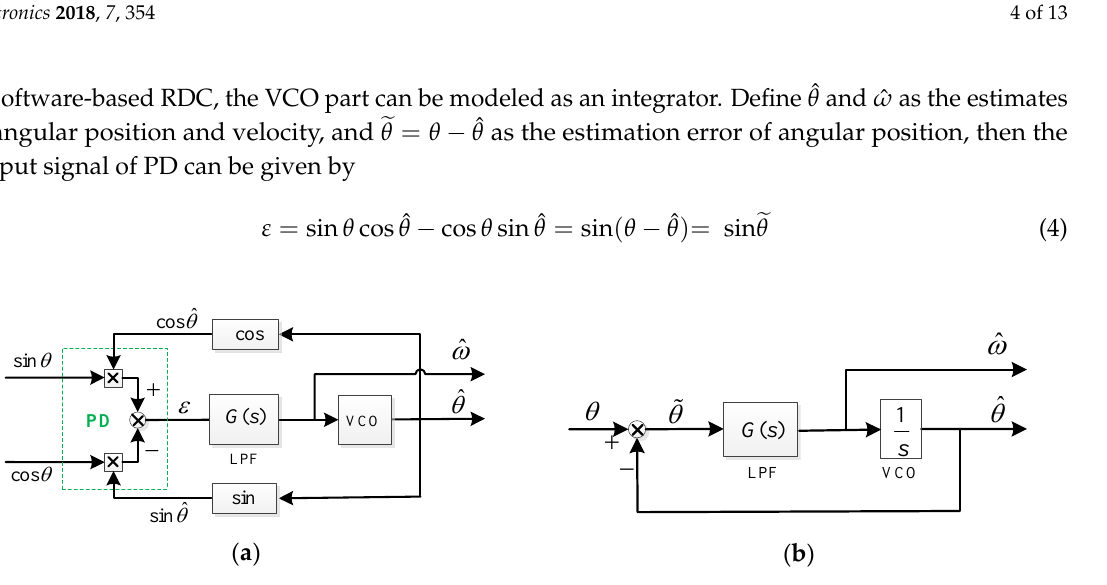
Figure 2. Block diagram of conventional PLL-based demodulation method. ( a ) Actual form; ( b ) simplified form.